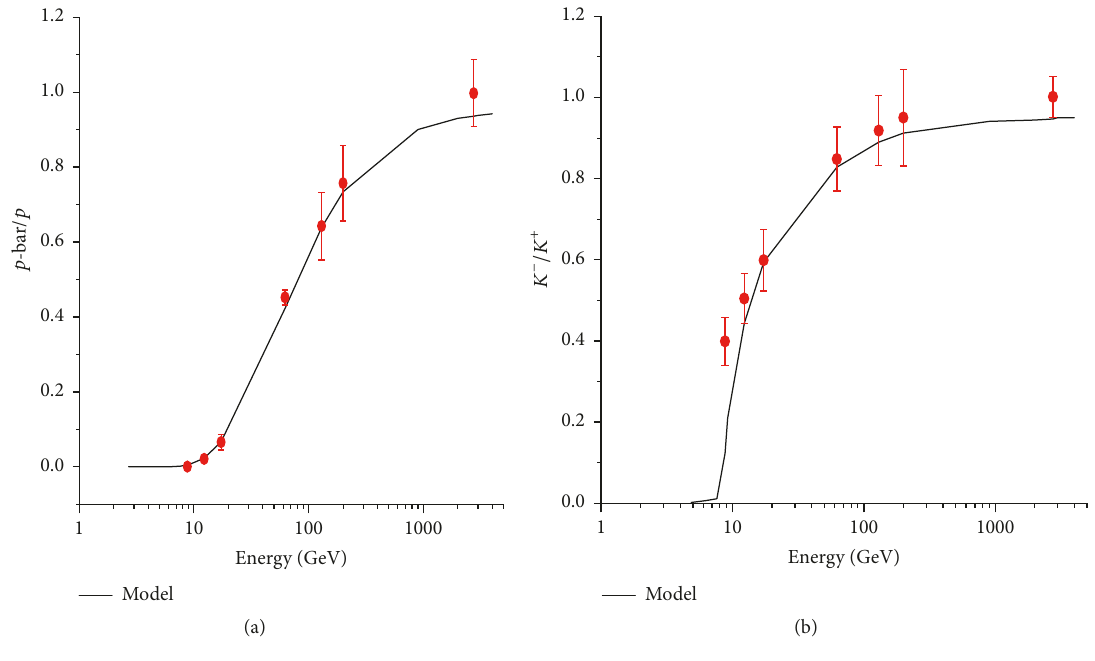
Figure 2: Energy dependence of 𝑝/𝑝 (a) and 𝑘 − /𝑘 + (b) ratios.